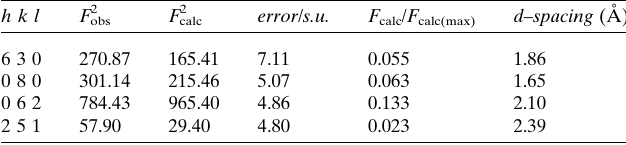
Table 4 List of the top four poorly fitting reflections for the model of the di- selenide shown in Fig.